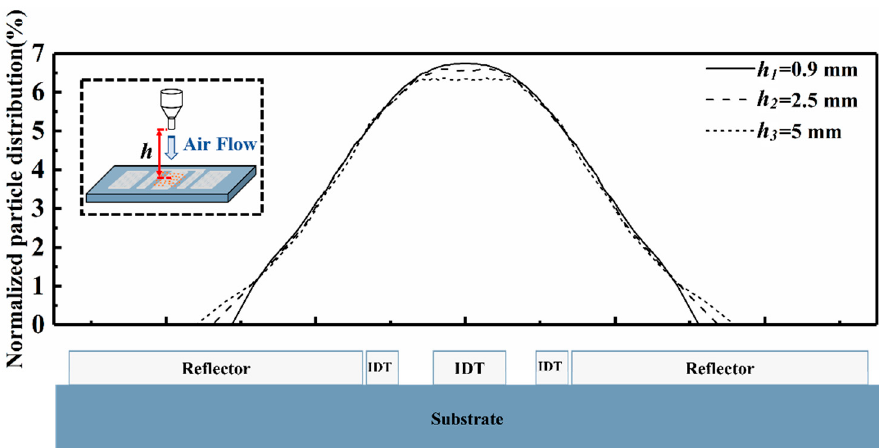
Figure 7. The normalized distribution of particles at different impact distances.